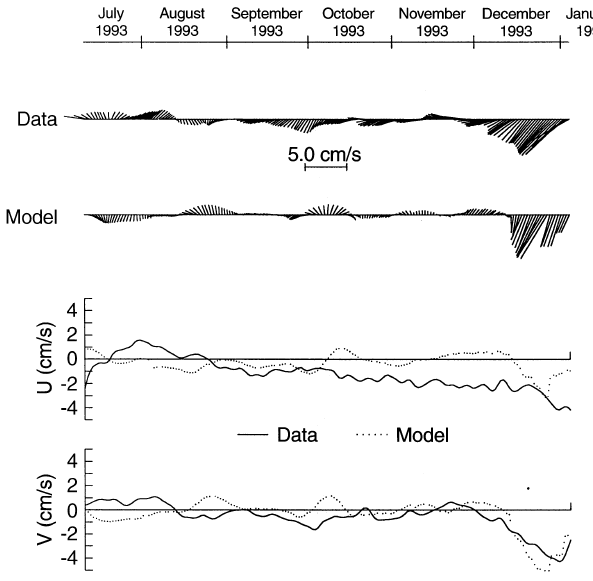
Fig. 8. Comparison of the velocities provided by the sub-surface drifter 17492 (immersed at 2200 m depth) and by the model along the drifter path. The vectorial correlation is 0.42 Table 2. Vectorial correlation (total correlation and relative angles) between the sub-surface drifter velocities and the